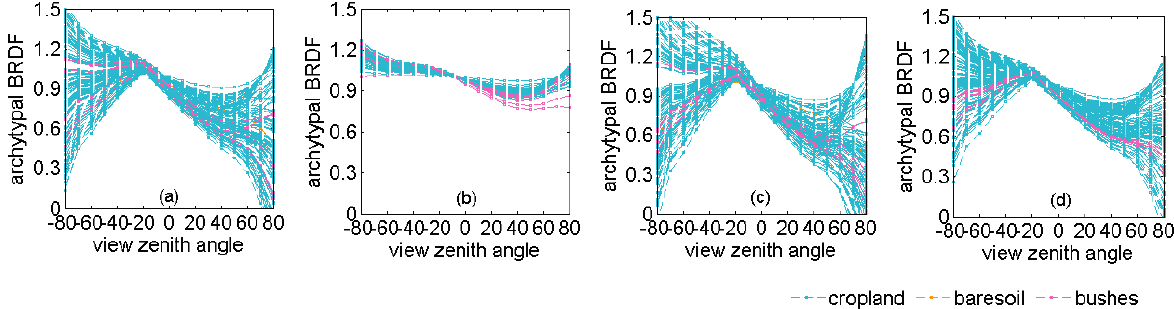
Figure 10. The archetypal BRDFs of the best-quality marked pixels from MCD43A1, ( a – d ) show bands 1 to 4,